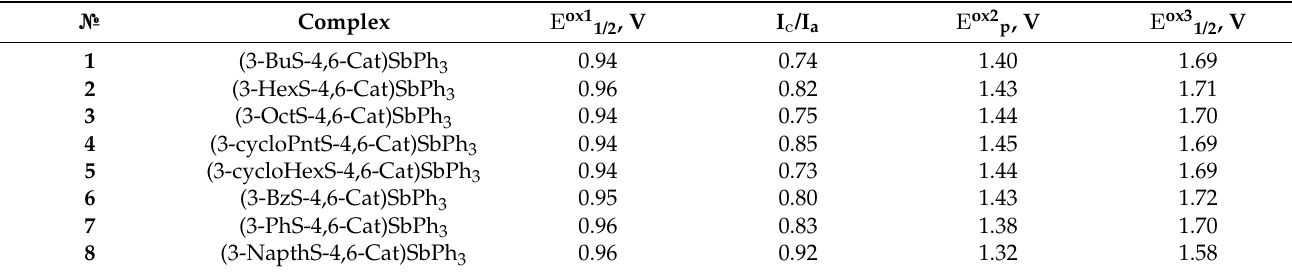
Table 2. The cyclic voltammetry (CV) data for 1 – 8 ( vs. Ag/AgCl/KCl(sat.)).